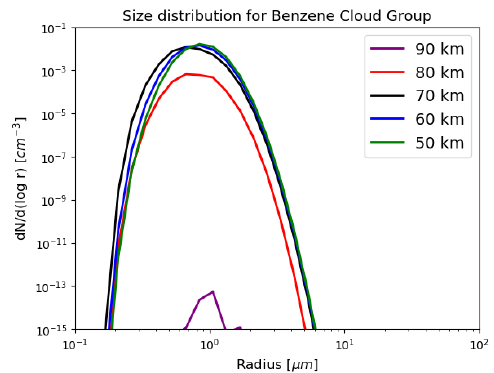
Figure 4. Size distribution of benzene ice particles in Titan’s atmosphere.